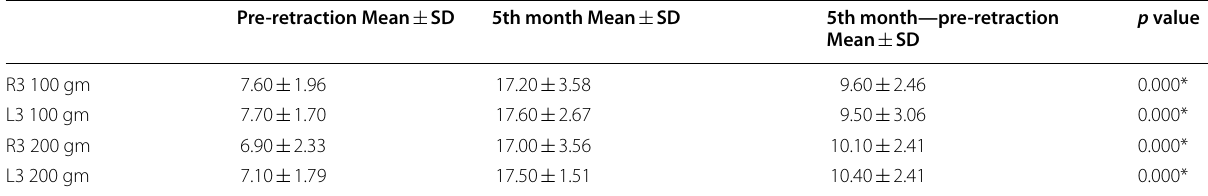
*Statistically significant at p value ˂